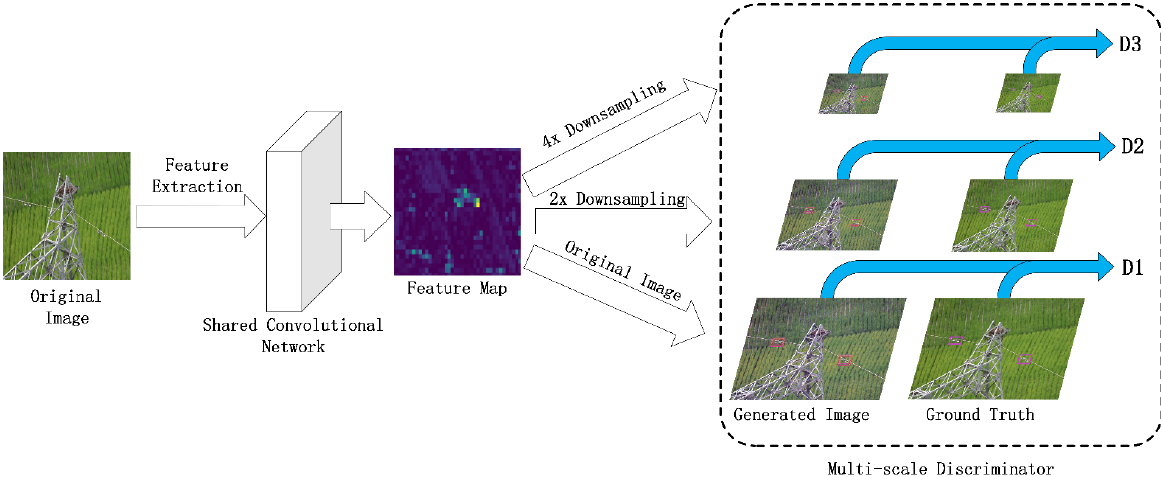
Figure 4. The discriminator consists of three parts with the same structure: D 1 , D 2 , and D 3 . First, we used the shared convolutional layer to obtain the feature map of input; then, the feature map was down ‐ sampled for 2 times and 4 times and output to D 1 , D 2 , and D 3 ; finally, we obtained the discriminator scores.